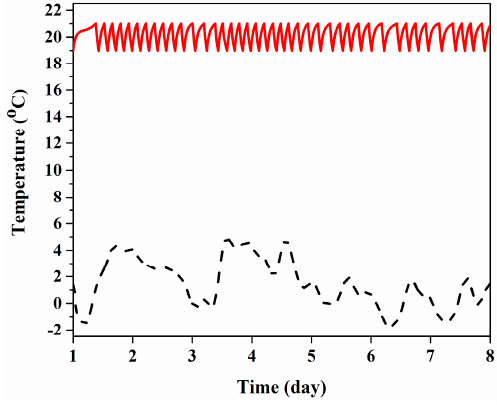
Figure 5. Indoor ( — ) and outdoor (- -) temperatures in scenario 1.